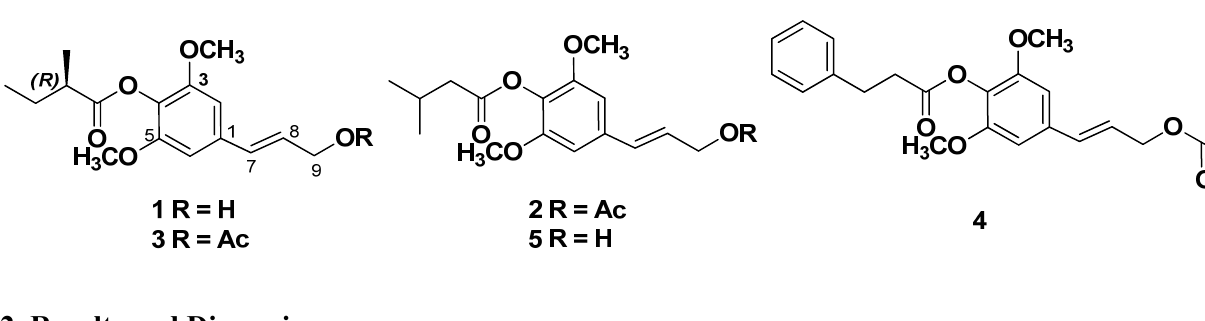
Figure 1. Structures of compounds 1 – 5